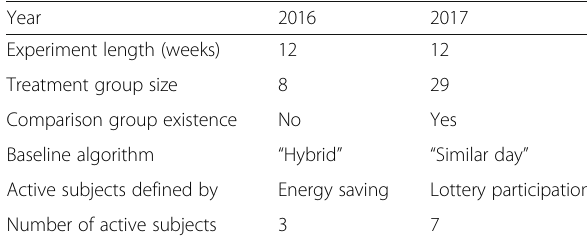
Table 2 Overview of EnergyCoupon experiments in year 2016 and 2017